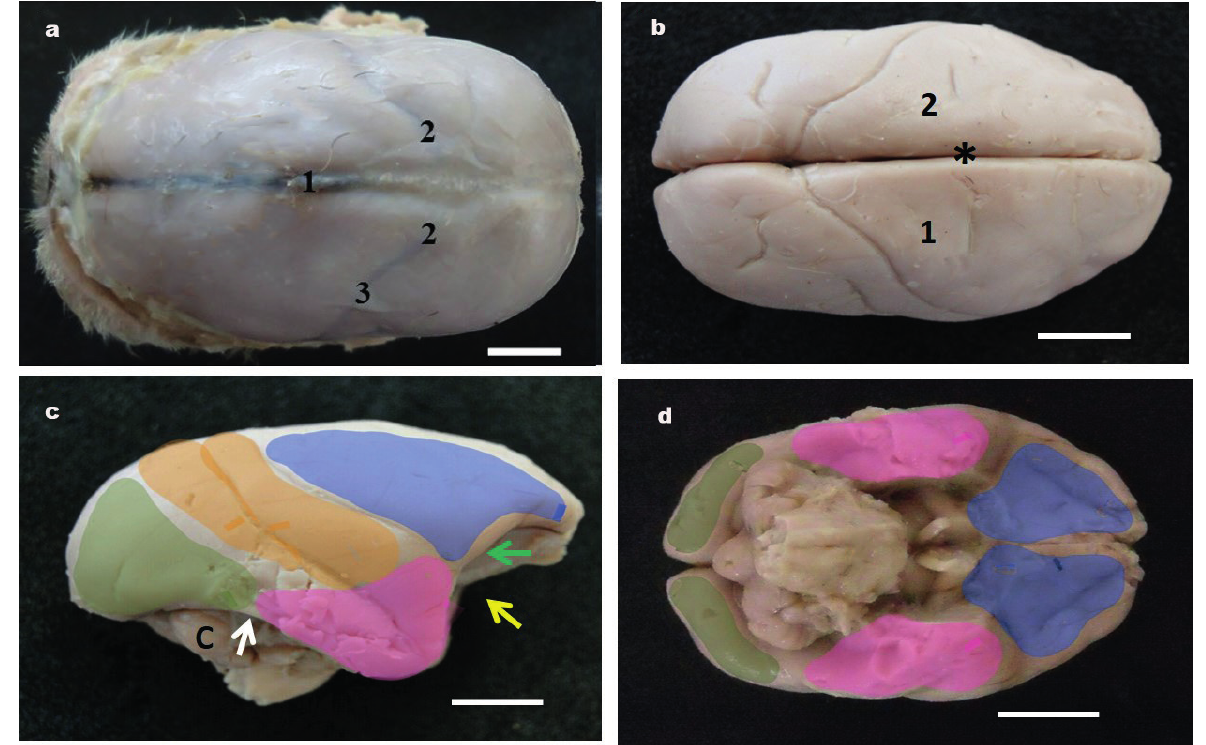
Figure 1 - Photomacrograph of the brain of Saimiri collinsi. (a) Dorsal view of the brain covered by dura mater in the cranial cavity after the removal of the temporal, frontal, parietal and a part of the occipital bones. Note the presence of the dorsal sagittal sinus (1), parietal bone (2) and temporal bone (3). (b) Dorsal view of the brain after the removal of the meninges, with a strong presence of longitudinal fissure (*) separating the right cerebral hemisphere (1) from the left cerebral hemisphere (2). (c) Side view of the brain without the meninges, which are observed the frontal lobes (blue), parietal (orange), temporal (pink) and occipital (gray), and the cerebellum (C). Note also the location of the nasal grooves (caudal - white arrow; cranial - green arrow), as well as ocular printing (yellow arrow). (d) Ventral view of the brain without the meninges, which are observed in the frontal lobes (blue), temporal (pink) and occipital (gray), and the bulb. Scale bar: